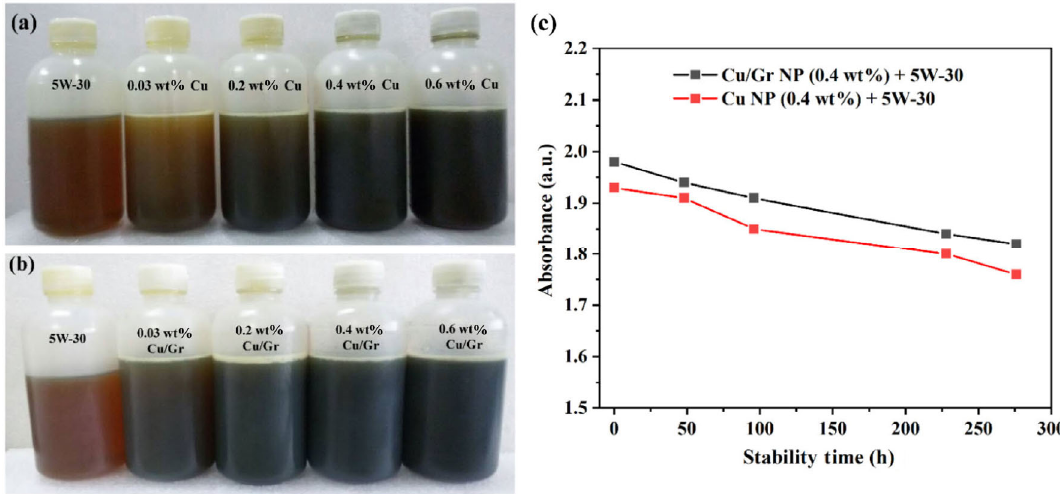
Fig. 3 Nanolubricant samples and the corresponding UV–vis analysis: (a) Cu nanolubricant, (b) Cu/Gr nanolubricant, and (c) variation in absorbance based on UV–vis analysis at different